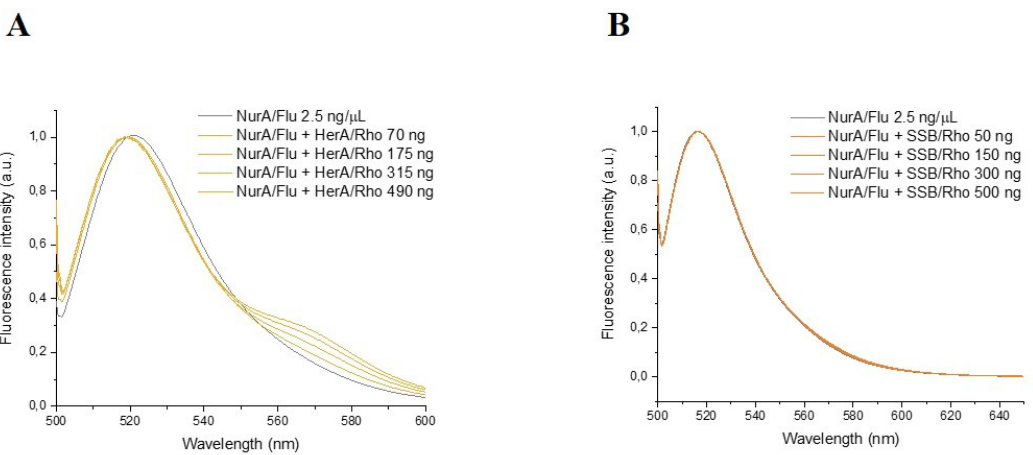
Figure 8. ( A ) Emission spectra of NurA labeled with fluorescein 5(6)-isothiocyanate in the presence of increasing concentrations of HerA labeled with rhodamine B. ( B ) Emission spectra of NurA labeled with fluorescein 5(6)-isothiocyanate in the presence of increasing concentrations of SSB labeled with rhodamine B. Buffer: 1 mM sodium phosphate buffer pH 7.0.